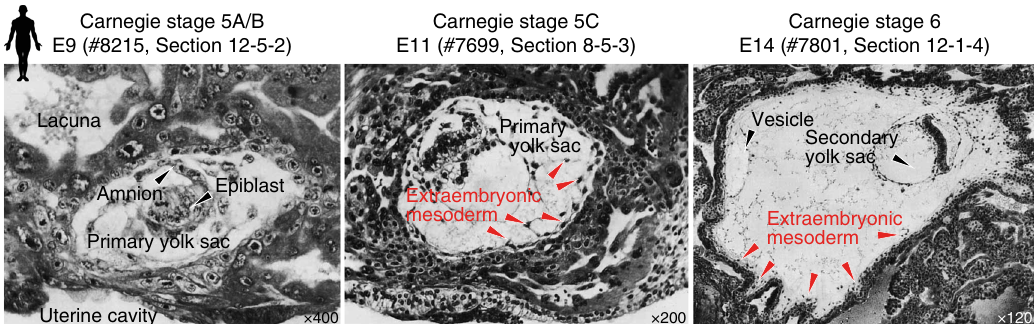
Fig. 4 Histology of early implantation stages in human. Embryonic stages are depicted according to Carnegie stage and embryonic day (E) with the Carnegie specimen and section ID indicated. Images are reproduced from ref. 74 . Original annotations have been removed using the Adobe Photoshop Spot Healing